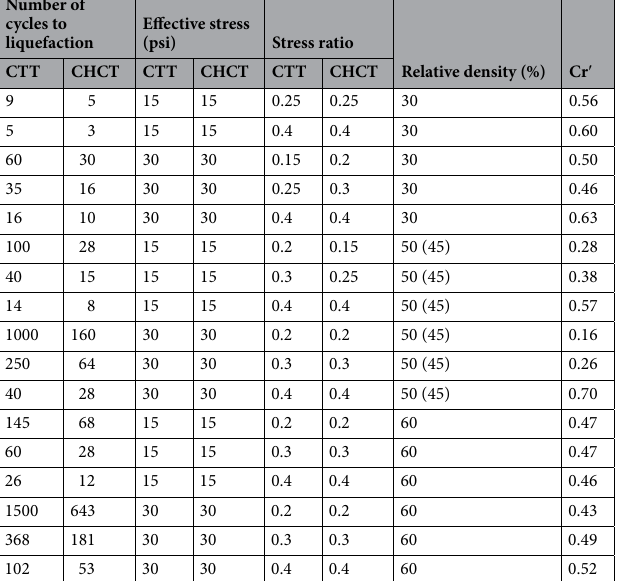
Table 4. Cr ′ values on medium clean produced in laboratory by CTT and